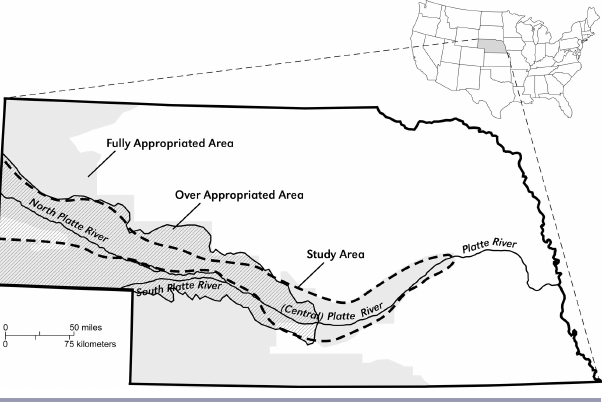
Fig. 1. Map of the Nebraska Department of Natural Resources and Natural Resources Districts in the fully- and overappropriated portions of the